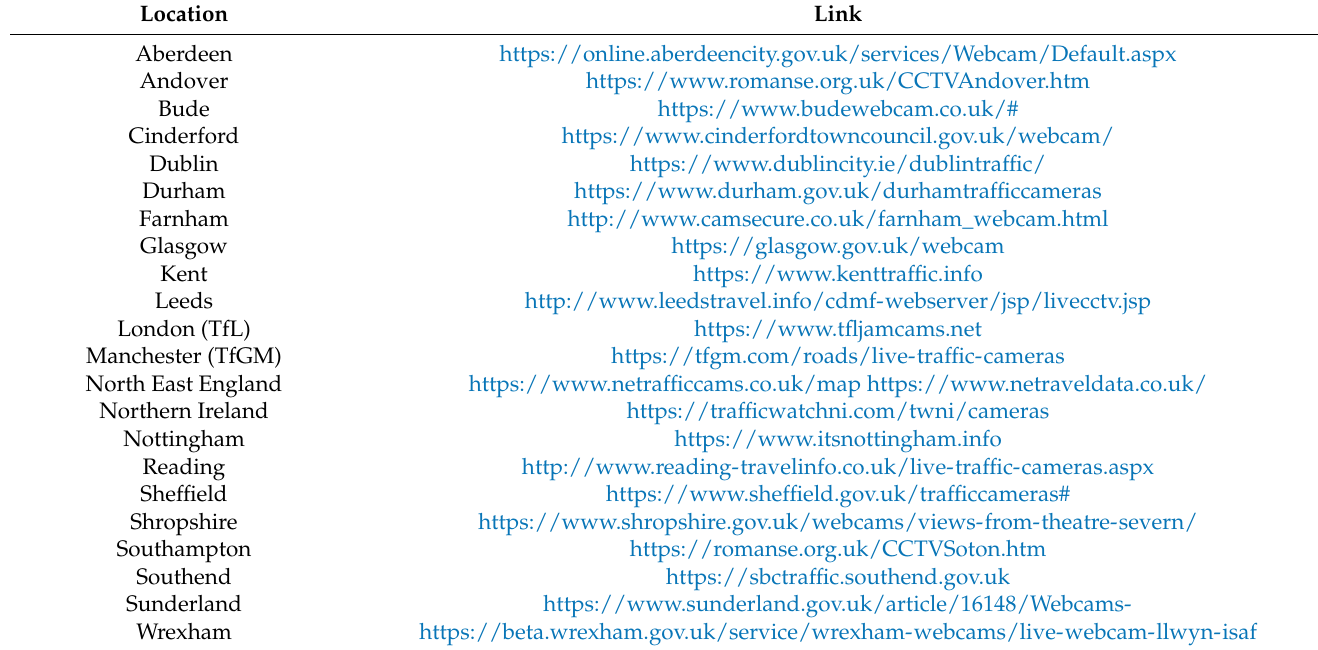
Table A1. Publicly available camera sources identified as part of this research. The links are accessed on 28 June 2021.